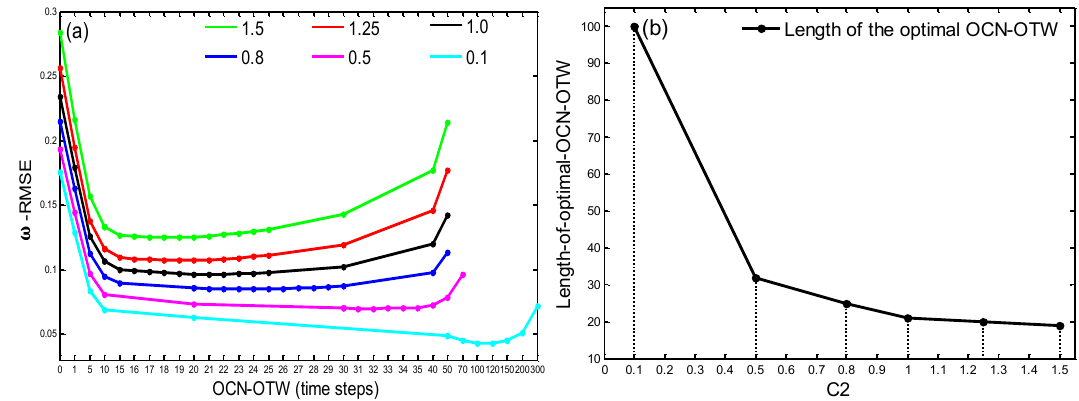
Figure 10. Panel (a) is the same as panel (b) in Fig. 9 but for using six different coupling strength cases (with C 2 values of 1.5, 1.25, 1.0, 0.8, 0.5, and 0.1, while C 1 stays as 0.1). Panel (b) is the variation of the length of the optimal OCN-OTW with respect to the values of C 2